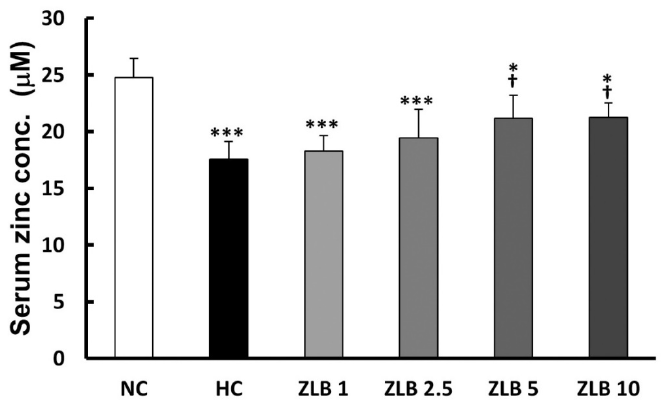
Figure 8. Serum Zn 2 + concentration after ZLB administration. The serum Zn 2 + concentration was measured by a zinc colorimetric assay kit. NC, normal diet control; HC, high-fat-diet (HFD) control; ZLB1, ZLB2.5, ZLB5, and ZLB10, HFD with 1, 2.5, 5, and 10 mg / kg / day of ZLB. Values are expressed as mean ± SD (n = 6 per group). * P < 0.05 and *** P < 0.001 vs. NC group; † P < 0.05 vs. HC group.